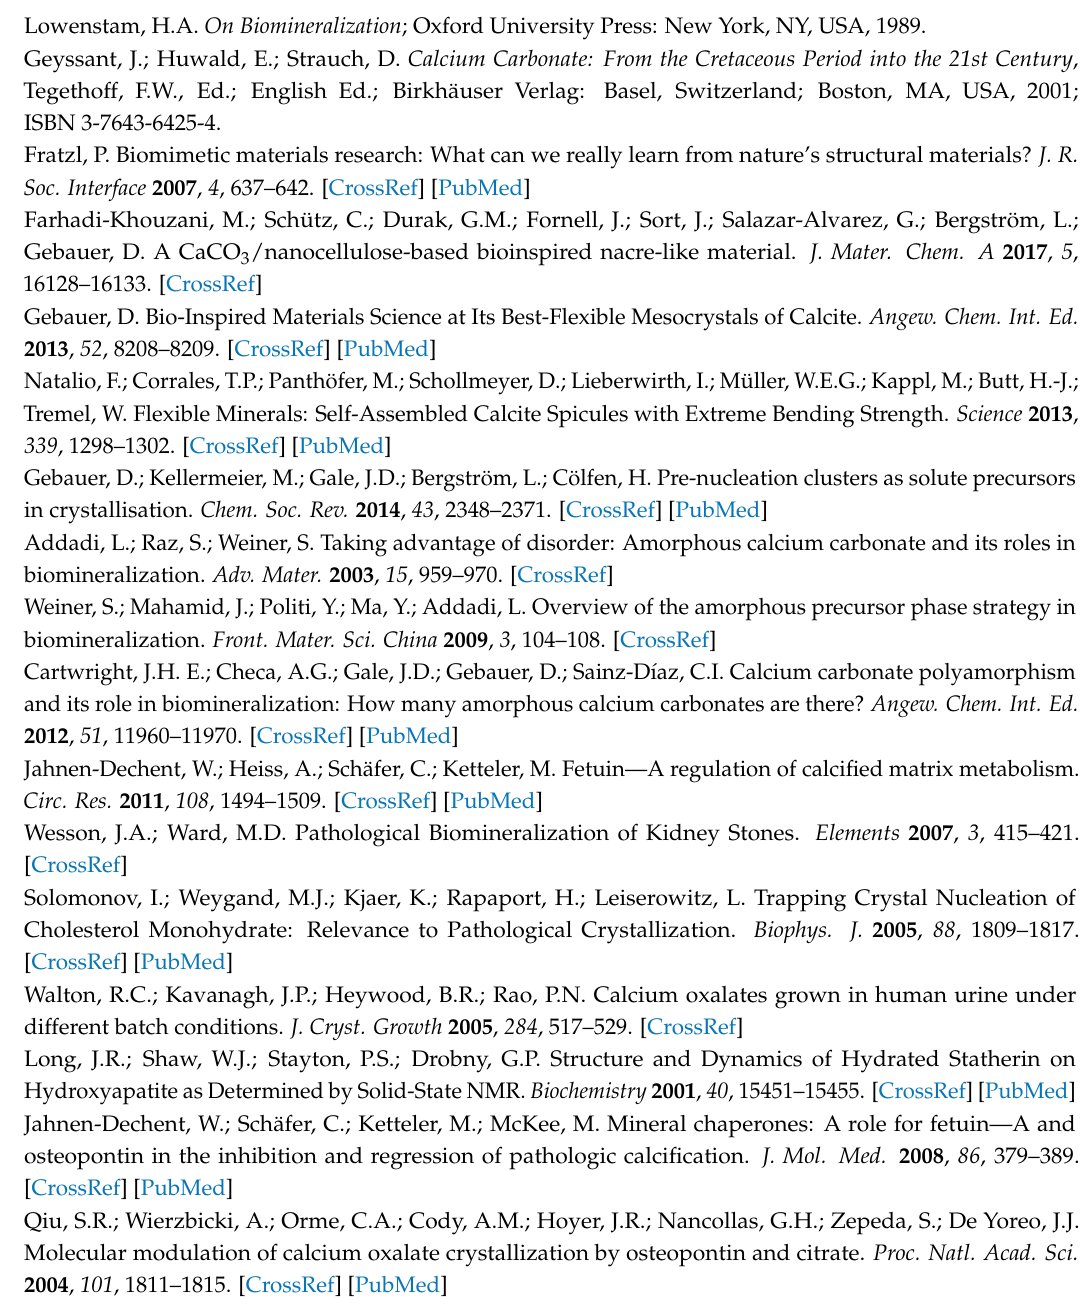
Figure S1: SEM micrograph with EDS mapping of a large area of the urinary stone of the Guinea Pig, Figure S2: SEM micrograph with EDS mapping of a smaller porous region of the urinary stone of the Guinea Pig, Figure S3: SEM micrograph with EDS mapping of a smaller dense region of the urinary stone of the Guinea